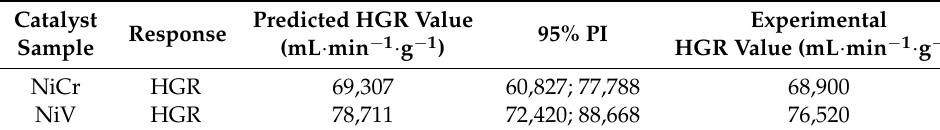
Table 4. Comparison of estimated and experimental HGR values.